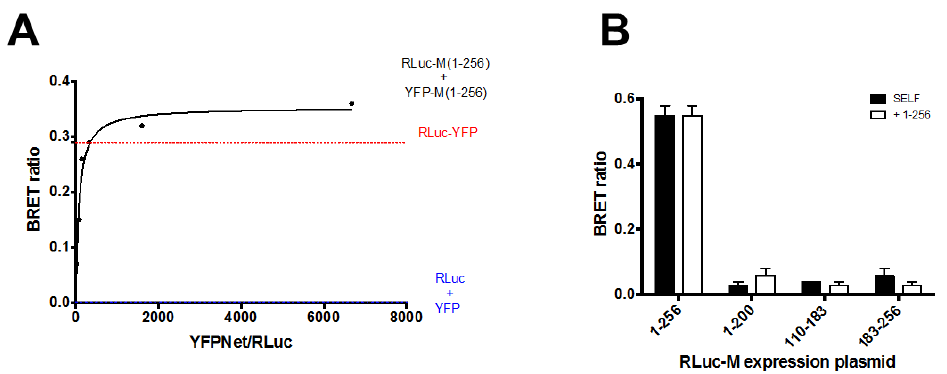
Figure 4. RSV M can self-interact in live Mammalian cells, depending on its N and C-terminal domains. ( A ) HEK293T cells were transfected to transiently express the RLuc-M (1–256) plasmid (0.5 ng) either in the absence or in the presence of increasing amounts the YFP-M (1–256) plasmid (range 0–450 ng). Alternatively, cells were transfected with the positive control plasmid RLuc-YFP (225 ng) or with plasmid RLuc-M (1–256) and pCMVFLAG-X-YFP as negative controls. 48 h later cells were processed for BRET measurements as described in the Materials and Methods section. The BRET ratio relative to the RLuc-M (1–256) and the YFP-M (1–256) BRET pair was plotted against the normalized YFPNet/RLuc ratio, and data used to calculate the Bmax and B50. The red dotted line indicates the BRET ratio obtained for the RLuc-YFP control protein, and the blue dotted line indicates the BRET ratio obtained for the RLuc-M (1–256) protein expressed in the presence of YFP alone. Representative data from four independent experiments are shown; ( B ) HEK293T cells were transfected to transiently express the RLuc-M expression plasmids either alone or in the presence of the indicated YFP-M expression plasmids. 48 h later cells were processed for BRET measurements as described in the Materials and Methods section. The BRET ratio relative to each condition is shown. Representative data from two independent experiments are shown. At 48 h post transfection, YFP fluorescent and BRET signals were acquired in living cells, and BRET ratios calculated, as described in the Materials and Methods section. Our results indicate that the RLuc-YFP fusion generated a BRET ratio of 0.34 ± 0.02 (Figure 4A), while the RLuc and YFP protein, generated a BRET ratio of 0. Importantly, co-expression of RLuc-M (1–256) and YFP-M (1– 256) generated a BRET ratio which rapidly increased with the ratio between YFP-M (1–256) and RLuc- M (1–256) expression levels (Figure 4A), and which quickly reached saturation. Data fitting allowed us to calculate the Bmax, corresponding to the maximal BRET ratio obtainable for the BRET pair (0.43 ± 0.04) and the B 50 , corresponding to the ratio between YFP-M (1–256) and RLuc-M (1–256) sufficient to generate a BRET ratio corresponding to half of the Bmax (48.4 ± 13.7). Overall, our results indicate that RLuc-M and YFP-M can interact with high affinity in live mammalian cells. 3.4. Deletion of N- and C-Terminal Portions of RSV M Affects Protein Ability to Form Dimers in Living Cells We next used BRET assays to evaluate the ability of M deletion mutants to self-interact and to form complexes with the full-length protein. To this end, HEK293-T cells were transfected with a series of plasmids encoding the above described M deletion mutants fused to RLuc, either in the absence or in the presence of YFP-M expressing plasmids. Each RLuc-M derivative was expressed in the presence of its YFP-tagged version, or in the presence of YFP-M (1–256). 48 h post transfection cells were processed for BRET assays to monitor protein self-interaction. As expected, we could calculate a strong BRET signal (0.55 ± 0.03) relative to the RLuc-M (1–256)/YFP-M (1–256) BRET pair (Figure 4B), consistent with the fact that full-length M is capable of self-interacting in living mammalian cells. However, very weak BRET signals were calculated for the RLuc-M (1–200)/YFP-M (1–200), RLuc-M (110–183)/YFP-M (110–183) and RLuc-M (183–256)/YFP-M (183–256) BRET pairs (0.03, 0.04, 0.06, respectively, see Figure 4B, black bars), indicating both N- and C-terminal domains